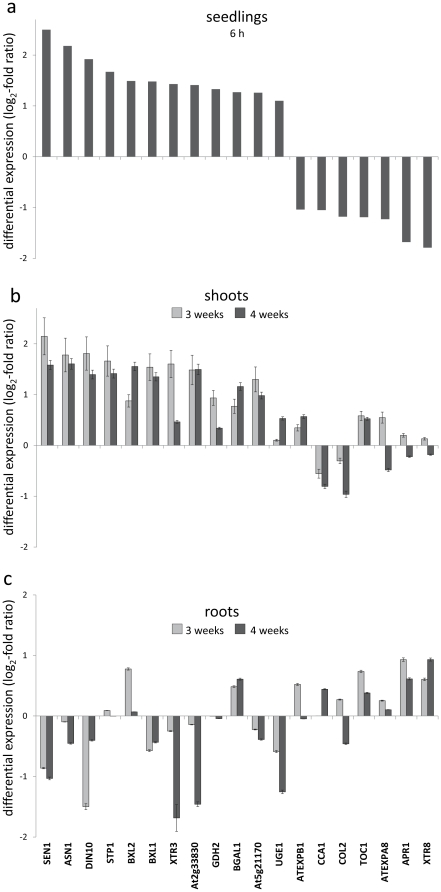
log2-fold expression values of P. sp. G62 - induced genes.a: selection of the most highly up- or downregulated genes (log2–fold change >1 or <−1) determined by microarrays 6 h after bacteria inoculation of 18-day-old seedlings. b, c: expression of the same genes determined by qPCR 3 and 4 weeks after seed inoculation, shoots (b) and roots (c), mean values ± SE.